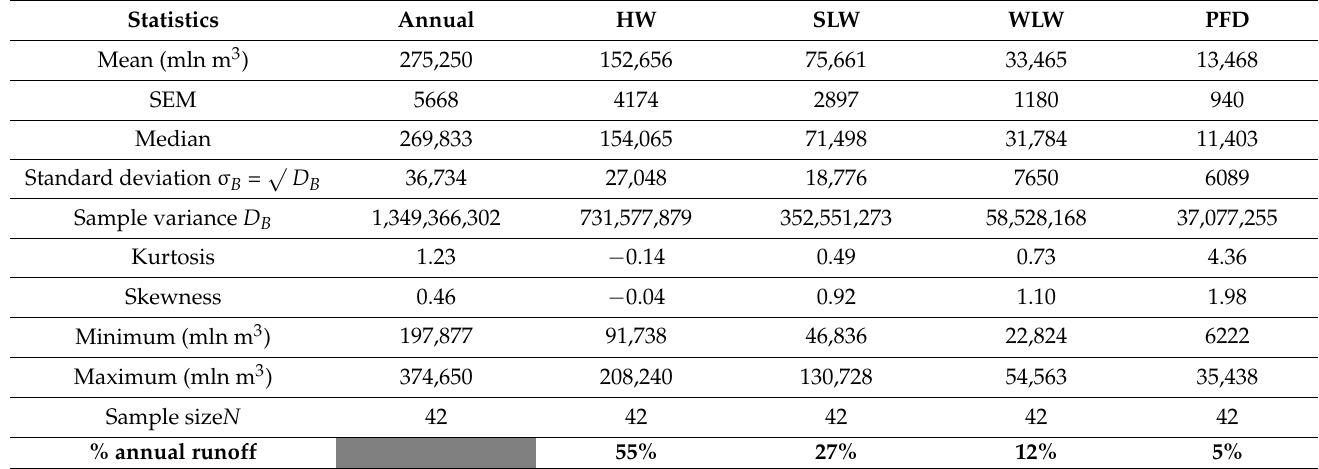
Table 8. The distributions’ numerical characteristics for the 1979–2020